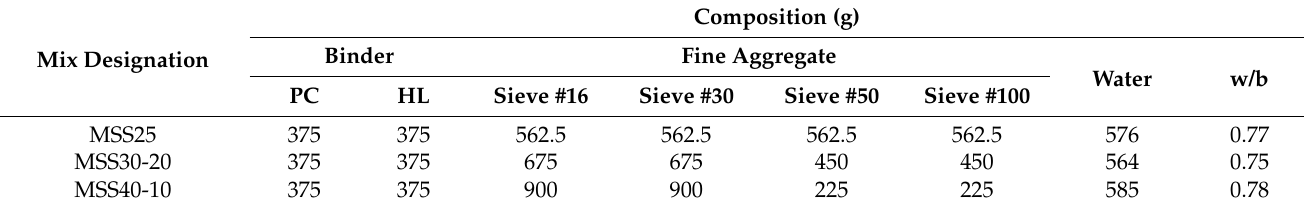
Table 3. Mix design of the